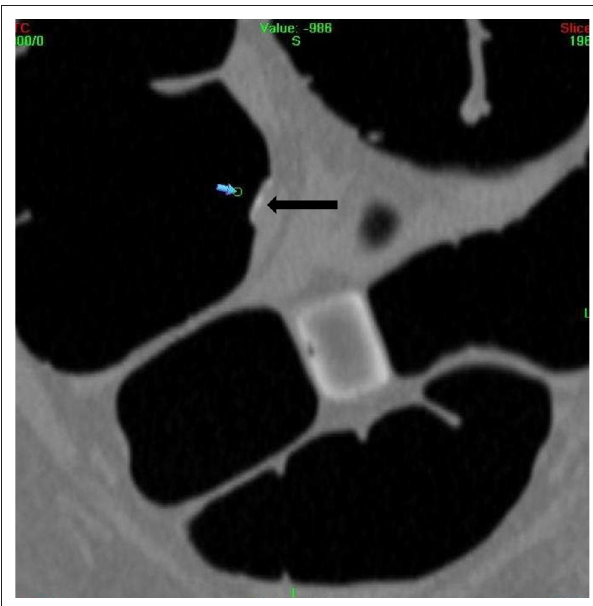
FIGURE 7: Barium covering flat polyp (black arrow).